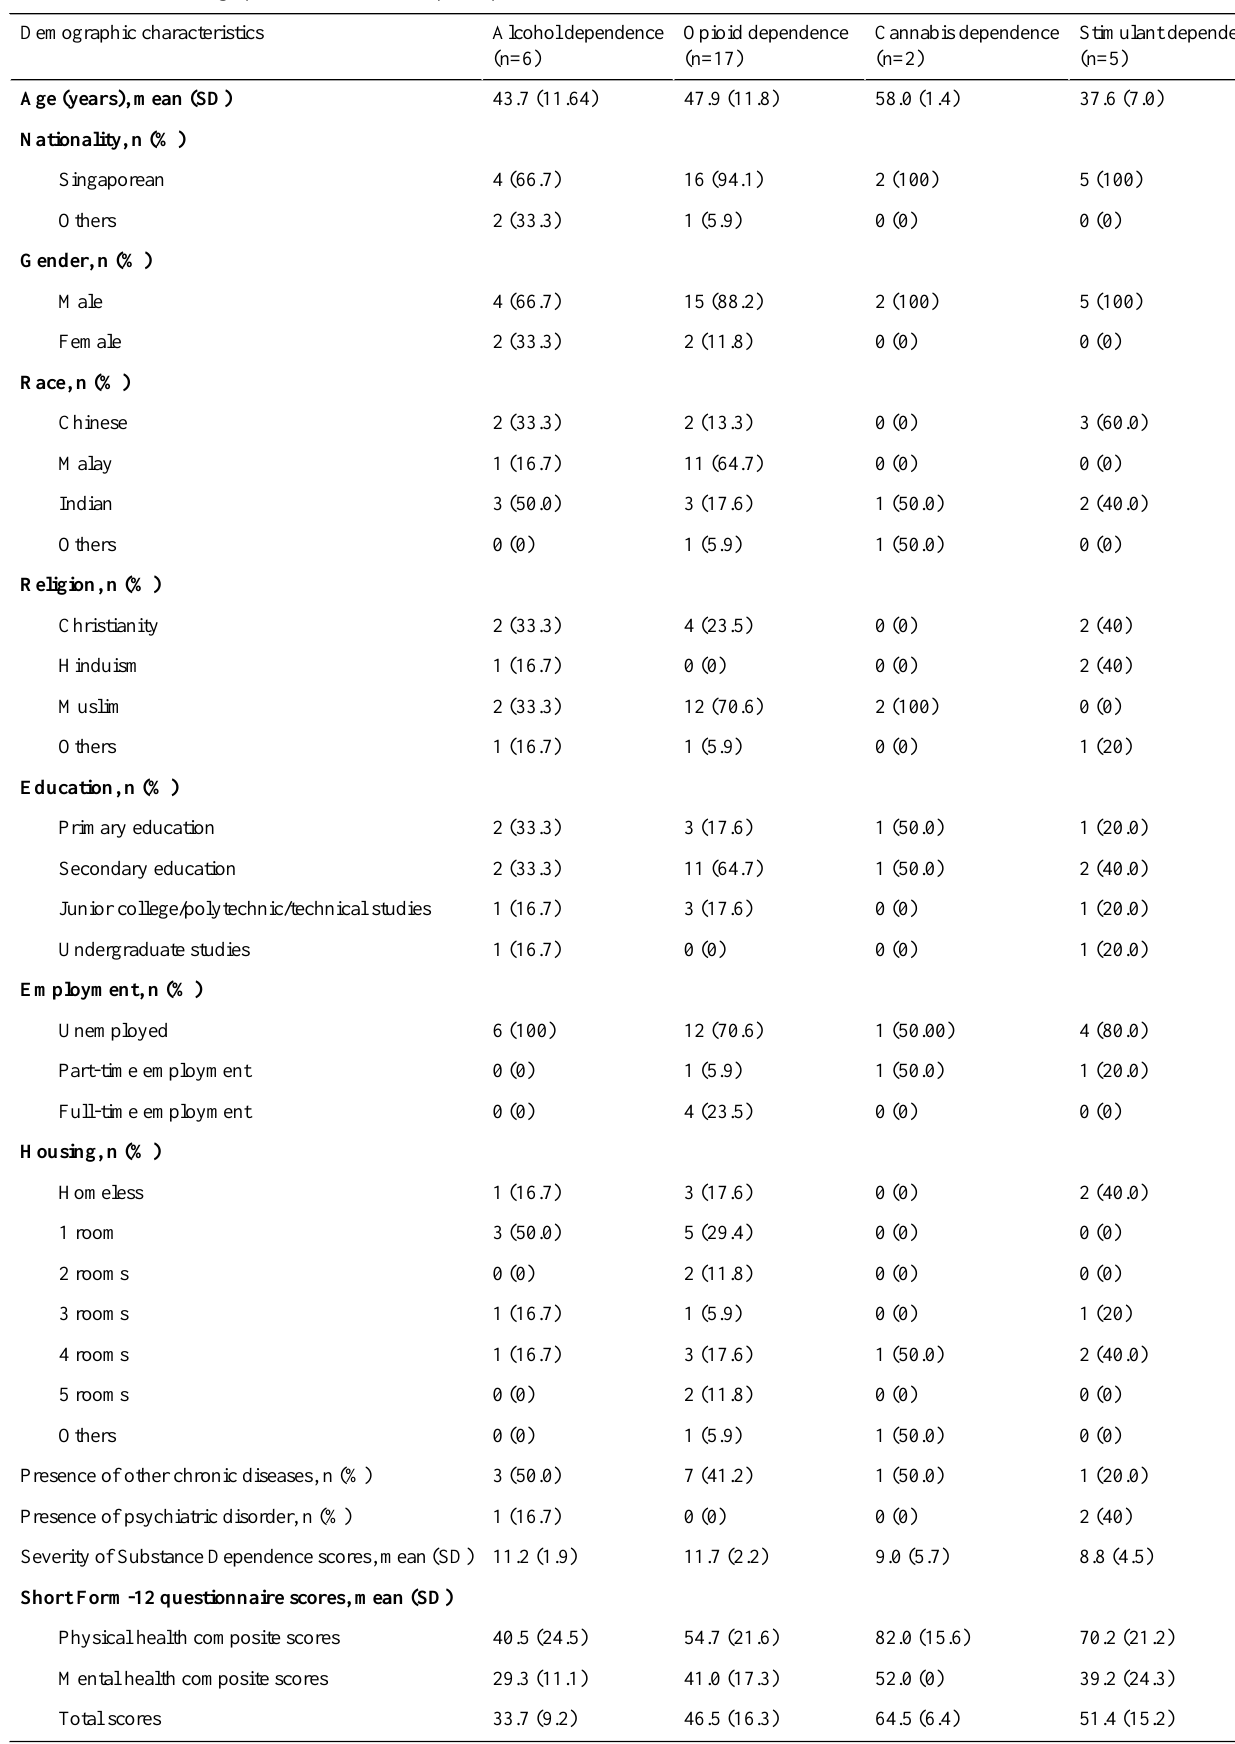
Table 1. Baseline demographic characteristics of participants